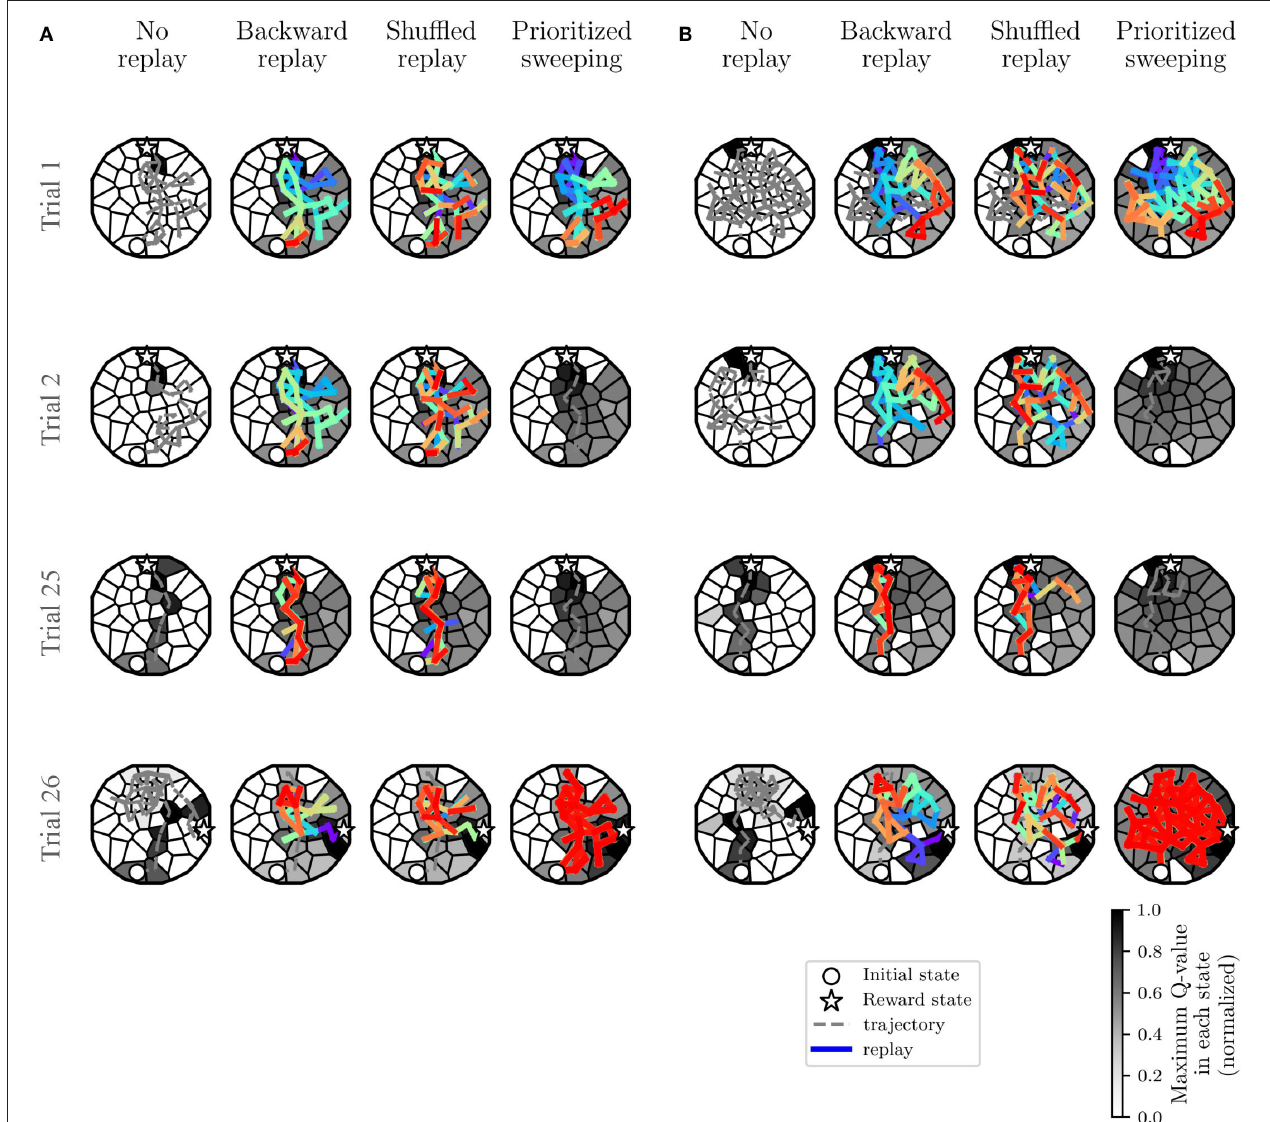
FIGURE 6 | Learning dynamics of the most representative individual: covered trajectory and replay at some critical trials. Also, for each state s , the maxQ ( s , a i ), among all the a i , with i from 1 to 8 ( Figure 8A , top right), is represented. The initial state and the reward state are also represented in the figure. (A) Experiments in the deterministic MDP. (B) Experiments in the stochastic